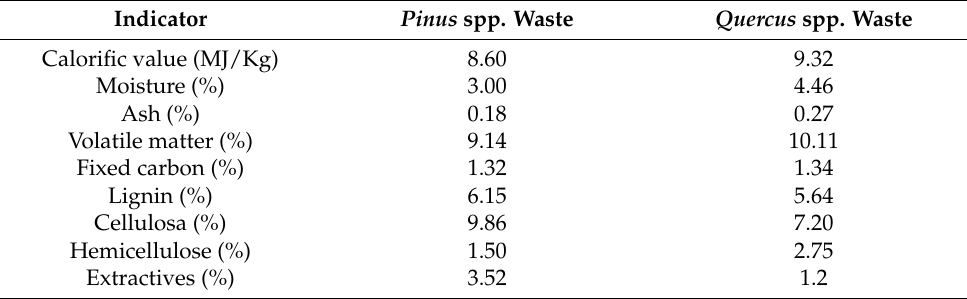
Table 7. Normalized values for the analysis.